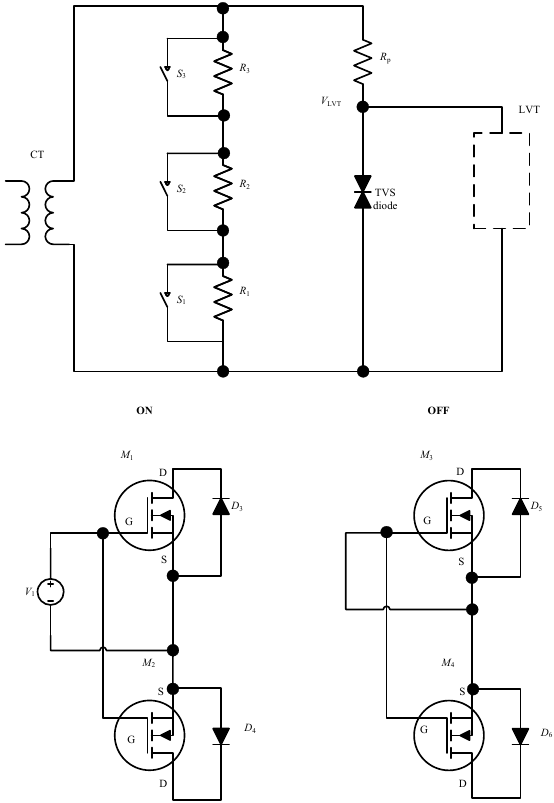
Figure 4. Illustration of the autoranging concept.